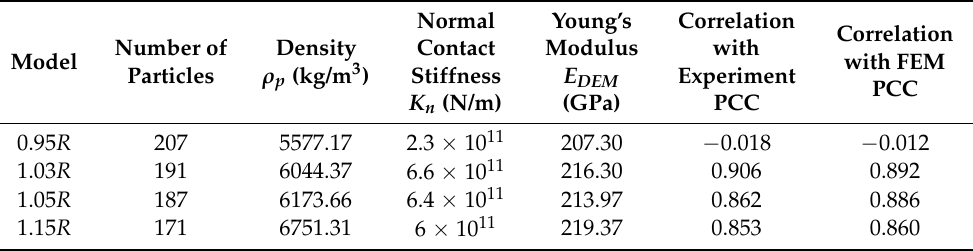
Figure 7. Comparison of signal for selected DEM models (various overlap) and frequencies. Correlation calculations were performed using the PCC to determine which model is the most unambiguously compatible with the experiment. Table 1 shows the estimated static parameters for selected models with different particle distances with correlation co- efficients. The comparison is intended to show the influence of the agreement distance parameter on the obtained agreement with reference (experimental) measurements and FEM calculations. A strong effect of the distance applied in the DEM model on the ob- tained correlation can be observed. This confirms previous observations, that the signals received for d = {1.03 R, 1.05 R, 1.15 R } are comparable. Their average correlation coefficients (for all particular frequencies) indicate high similarity. However, this requires verification over a wider frequency range. Table 1. Properties of DEM models.